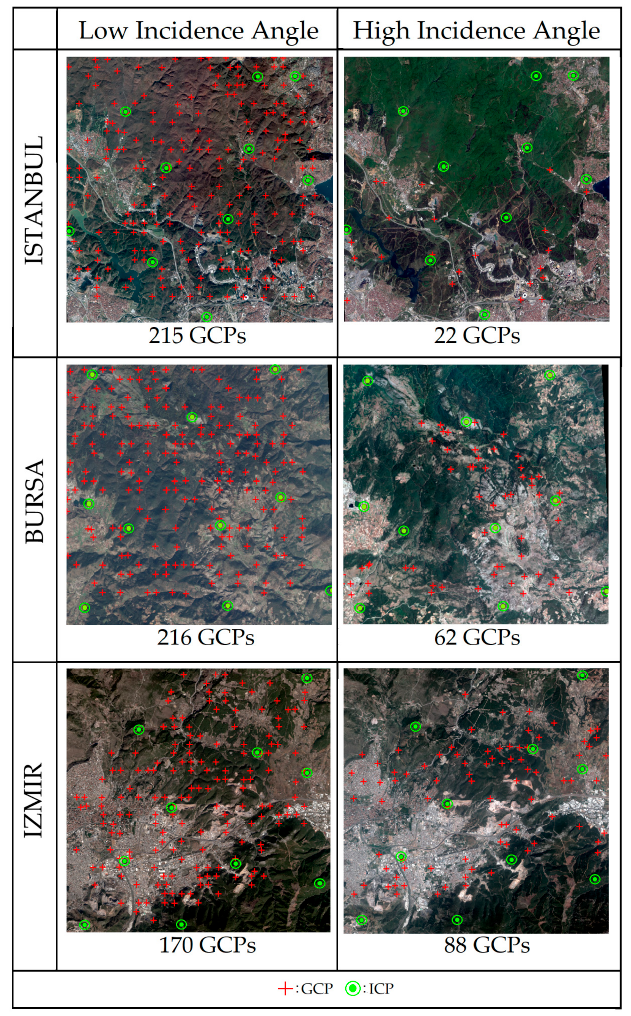
Figure A1. Distribution of the SIFT-based GCPs and Independent Check Points (ICPs) for the arithmetic mean of the RGB channels.